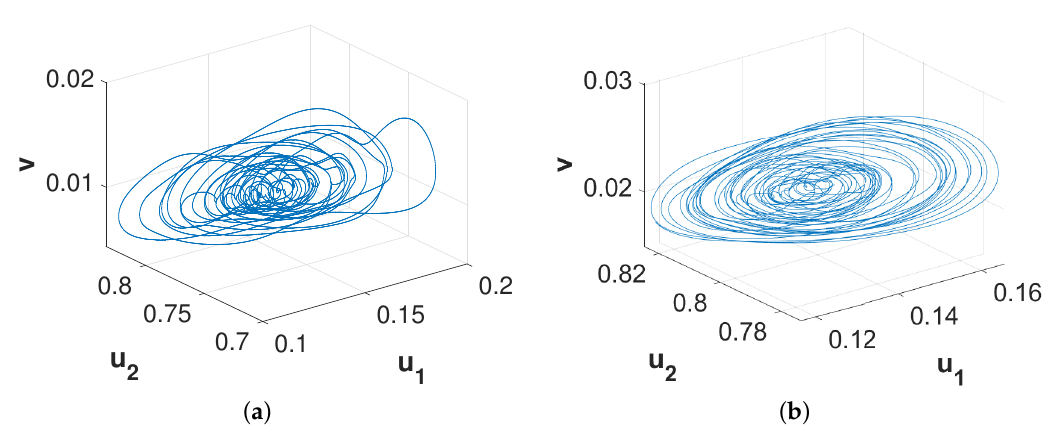
Figure 19. Phase diagrams of spatial average densities of the associated three species corresponding to ( a ) Figure 18a, ( b ) Figure 18b.